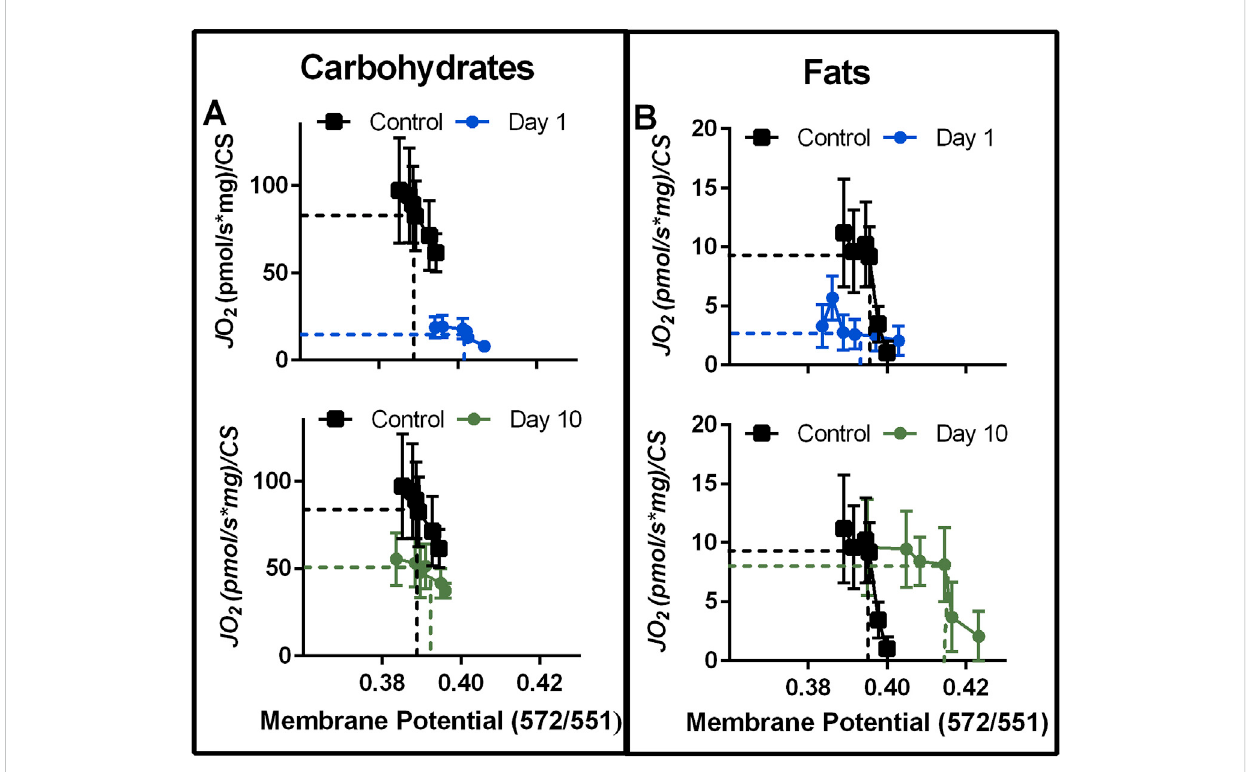
FIGURE 3 Representative time course of VML effect on the mitochondrial respiration — mitochondrial membrane potential relationship with carbohydrate or fat fuels. (A, B) The relationship between mitochondrial membrane potential and JO 2 with carbohydrate fuels (A) and fat fuels (B) at 1 and 10 days post- VML injury relative to uninjured control. Data re fl ects JO 2 and mitochondrial membrane potentials during the CK Clamp experiment. In both panels, dashed lines highlight JO 2 and membrane potential relationships at − 13.52 Δ G ATP to help visualize shifting inter-relationships. Data are mean ± SD for JO 2